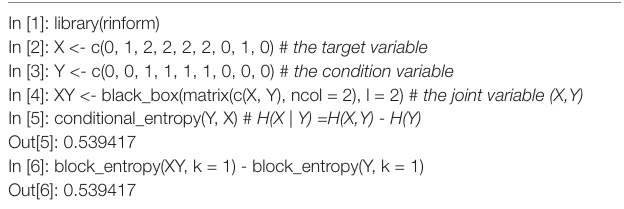
listing 12 | estimate active information of a time series using